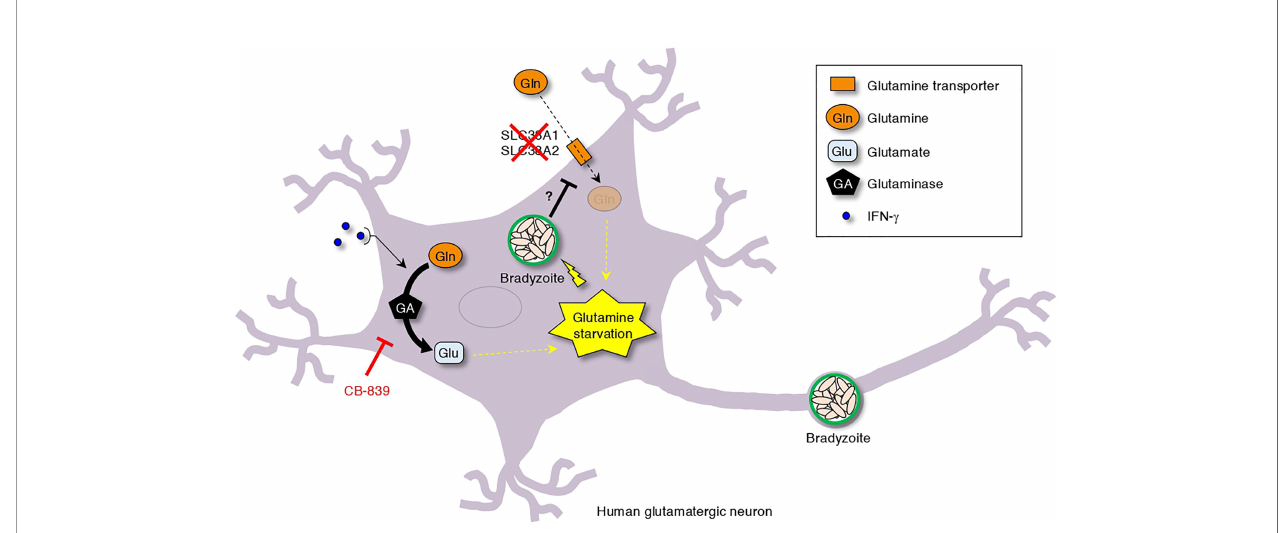
FIGURE 7 | Simpli fi ed scheme of T. gondii stage conversion in human neuronal cells. The dual effect of T. gondii infection-dependent inhibition of glutamine transporter activation and IFN- g -dependent glutamine degradation cause glutamine starvation, which triggers IFN- g -dependent T. gondii stage conversion in human neuronal cells. As shown, CB-839 treatment can prevent IFN- g -dependent T. gondii stage